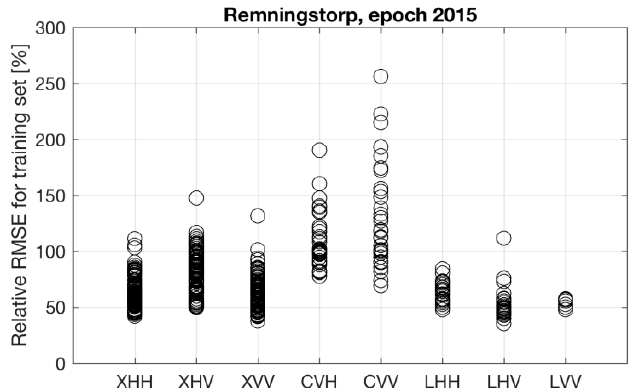
Figure 16. Relative RMSE or single image retrieval for the training set used to estimate stem volume shown in Figure 15. The individual relative RMSE values have been grouped in terms of frequency band and polarization.